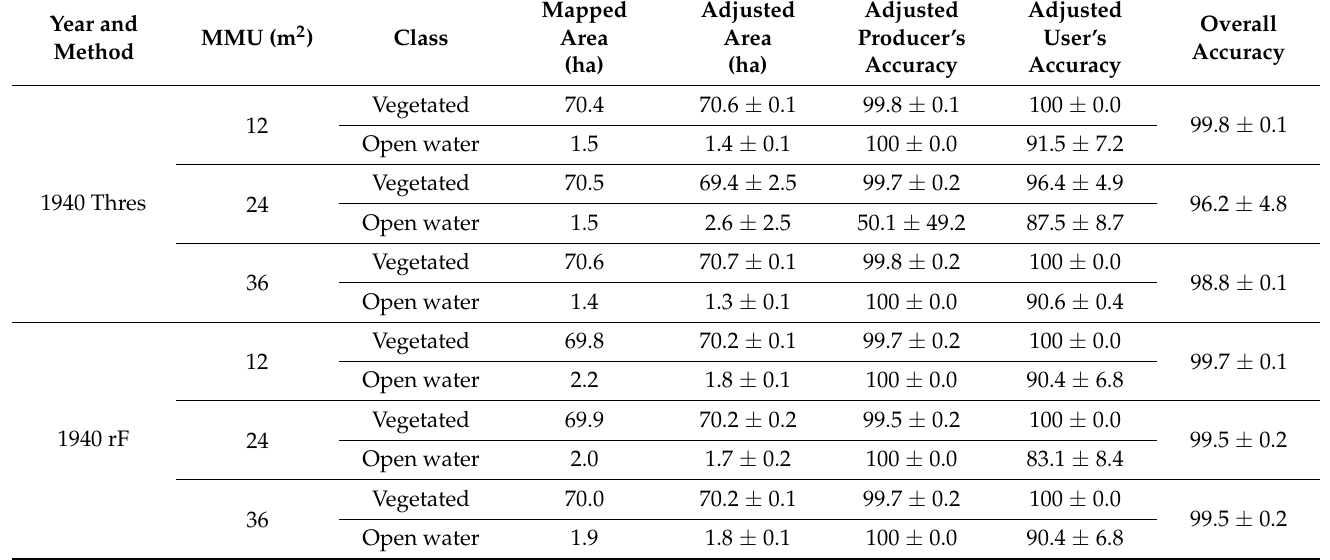
Table 2. Area-adjusted accuracy estimates (percent ± 95% confidence interval) as well as the total mapped area for wetland classifications for the 1940 panchromatic photograph and 2012 satellite image. Estimates are presented for each 1940 classification method, the 2012 classification, and each minimum mapping unit (MMU). Thres = threshold classifications; rF = random forest